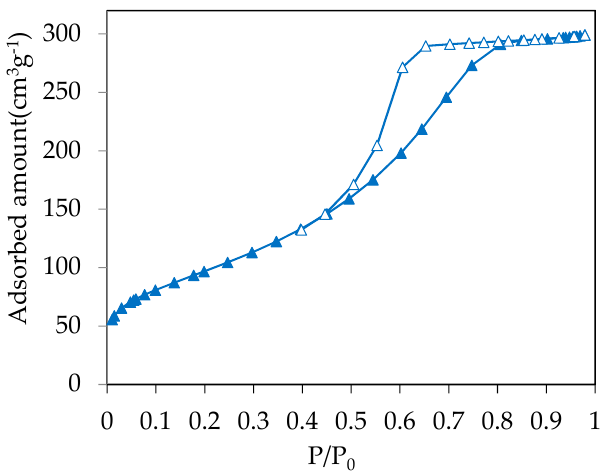
Figure 1. N 2 -adsorption-desorption isotherms for AlSi15 support (filled symbols indicate adsorption, open symbols indicate desorption). Table 2. Characteristic properties of powders used as coating phase.